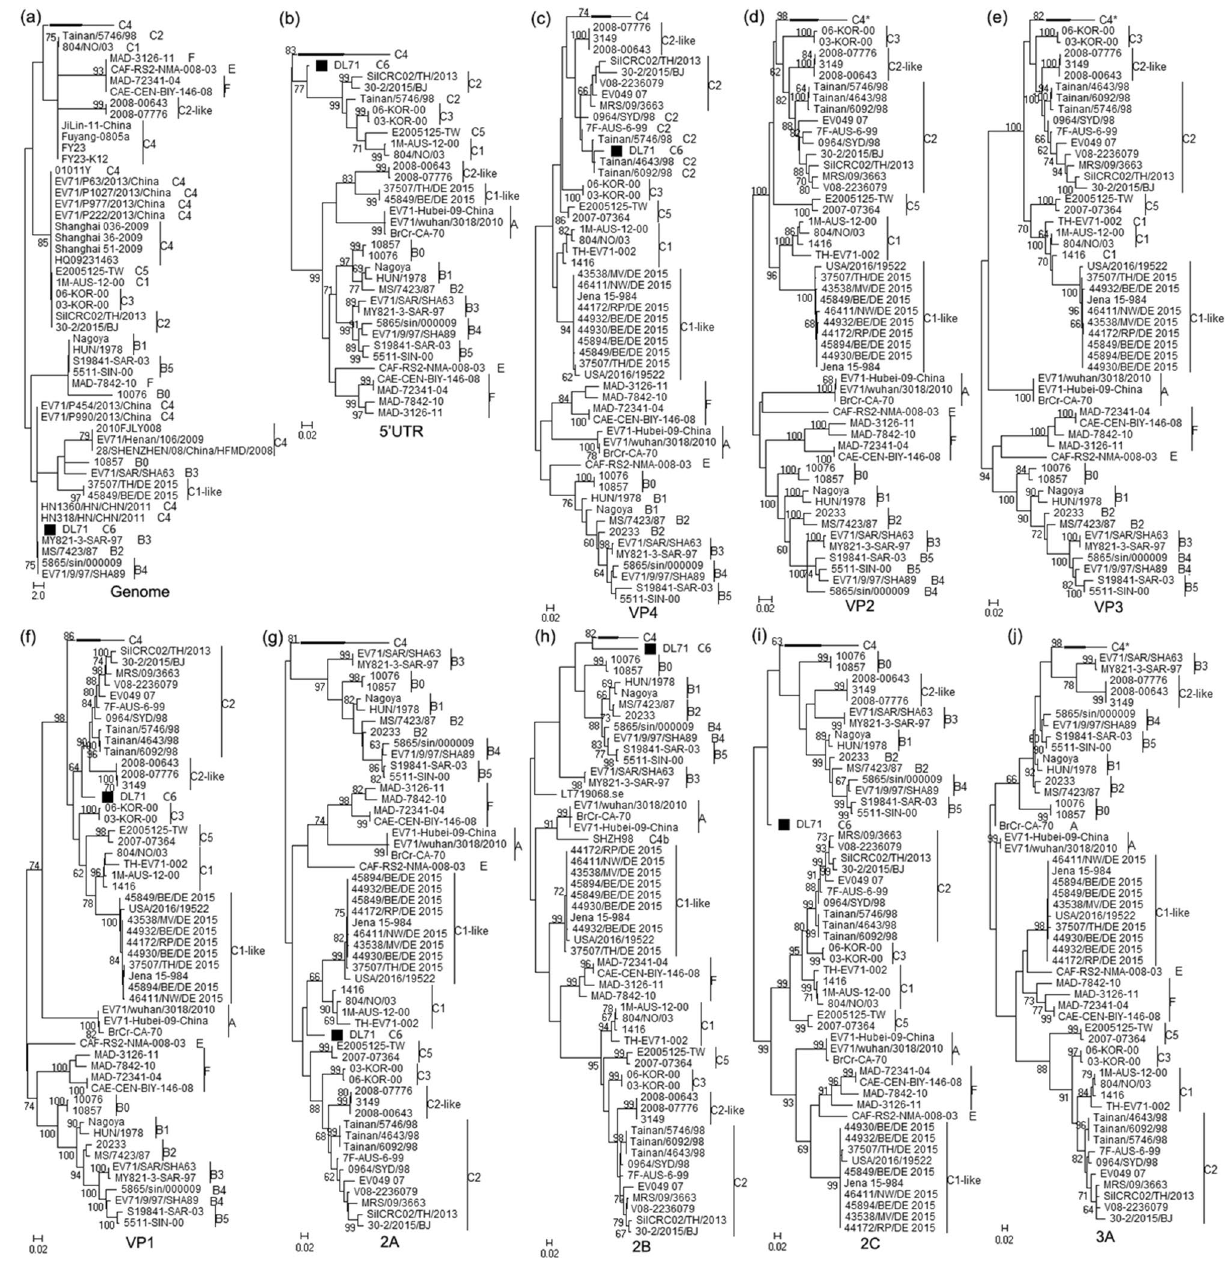
Figure 2. Phylogenetic trees based on the complete genomes and individual genes of DL71 and EV-A71 reference strains. The evolutionary trees based on ( a ) the complete genomes and individual genes ( b ) 5 ′